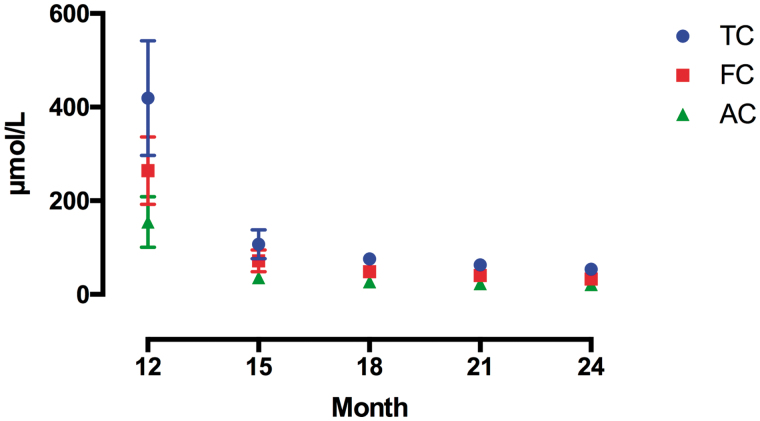
Levels of TC, FC, and AC after discontinuation of carnitine administration were found to be significant according based on the results of one-way ANOVA (p < .0001) and Dunnett’s multiple comparison tests (12 vs. 15, 12 vs. 18, 12 vs. 21, 12 vs. 24). TC: total carnitine; FC: free-carnitine; AC: acyl-carnitine.